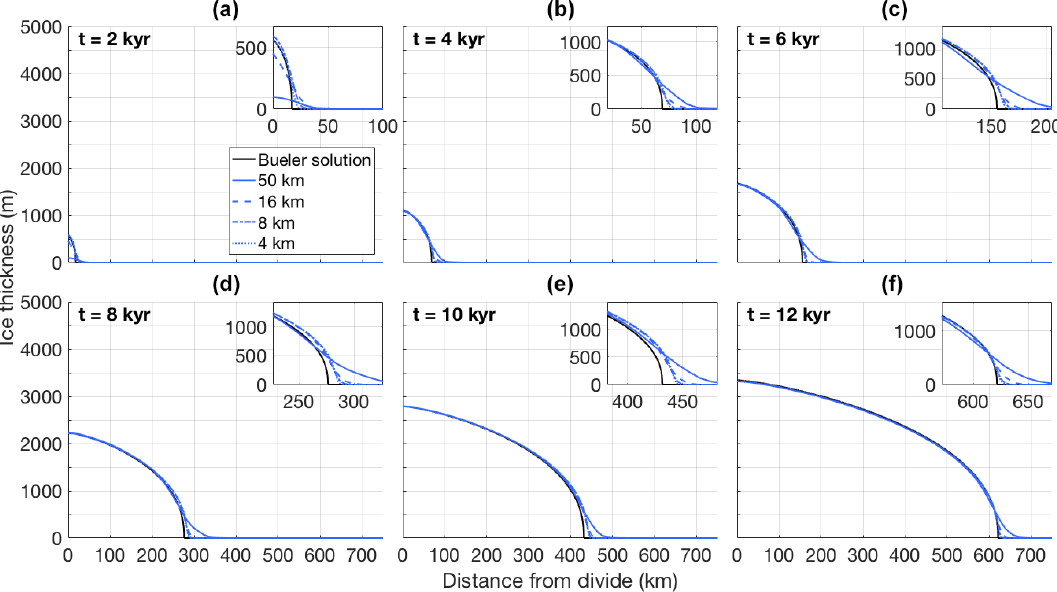
Figure 3. The evolution through time of a schematic, radially symmetric, isothermal ice sheet, with positive accumulation rate, as simulated by UFEMISM at different ice-margin resolutions, compared to the Bueler (2005)